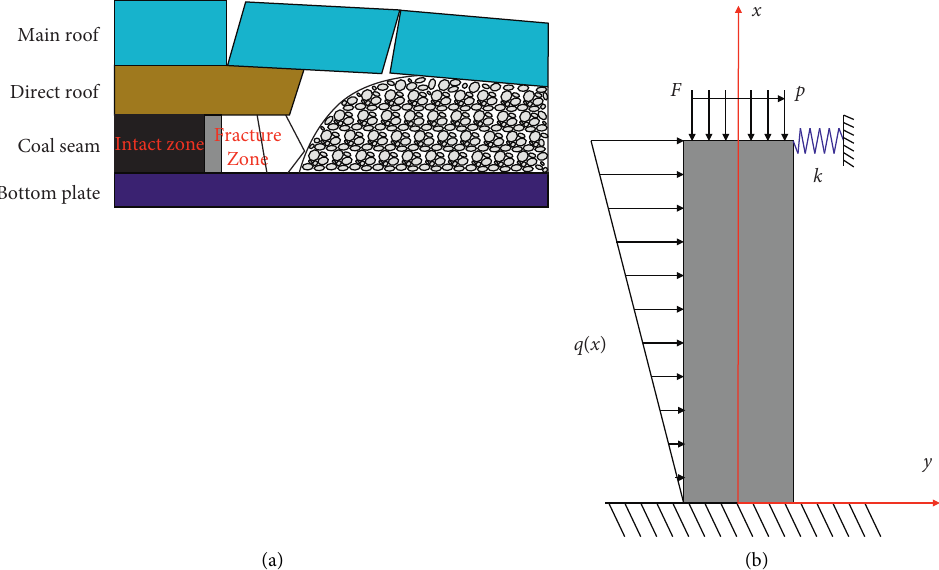
Figure 2: Mechanical model for a coal wall of a large height. (a) The various components around a section of high-wall coal mining. (b) Coal wall boundary